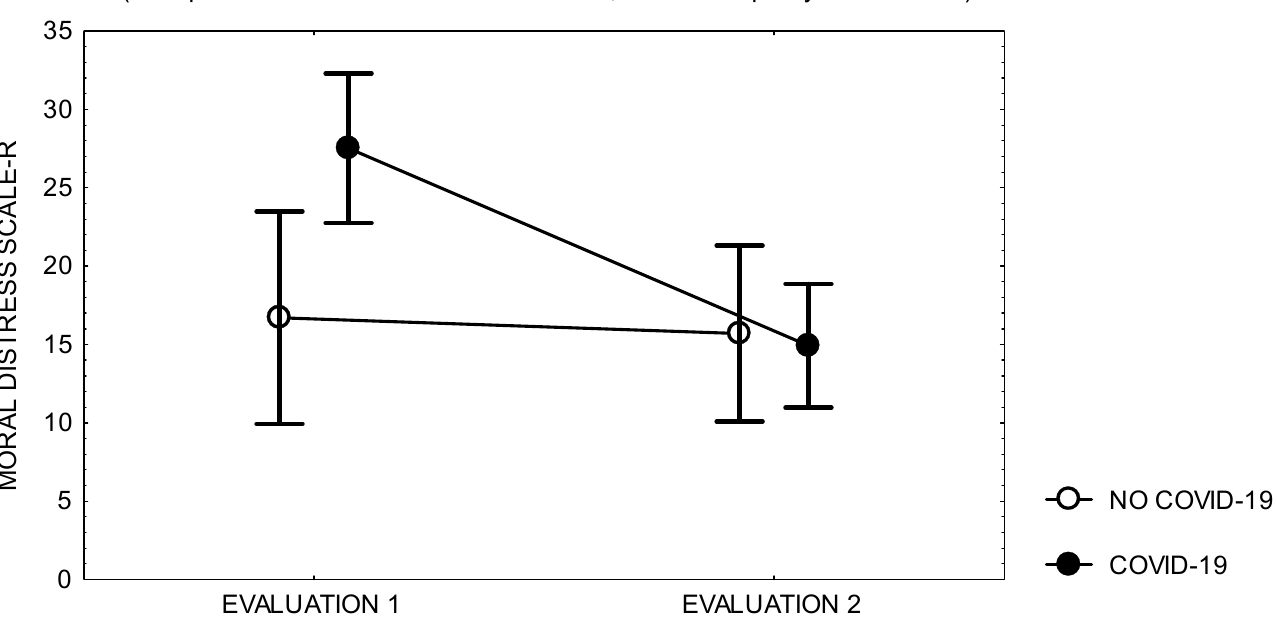
Figure 3. Mean and standard error of the mean of the scores on The Moral Distress Scale-R of 108 physicians in the two evaluations, according to the history of sick leave due to COVID-19. The multivariable analysis on the scores and the sub-scores of the Moral Injury Event Scale showed that (Table 6), in the first evaluation, the total score was related to the